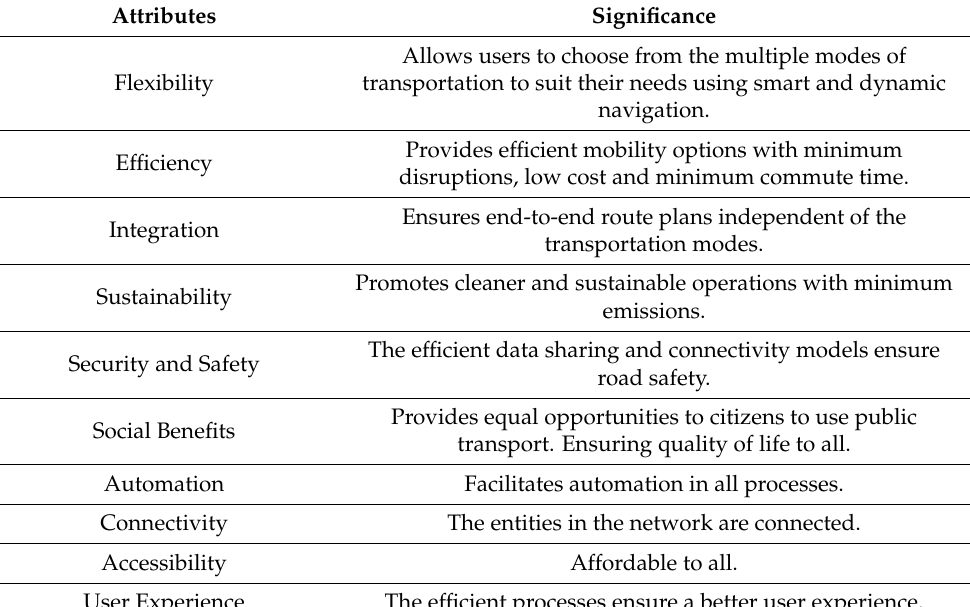
Table 2. Smart mobility